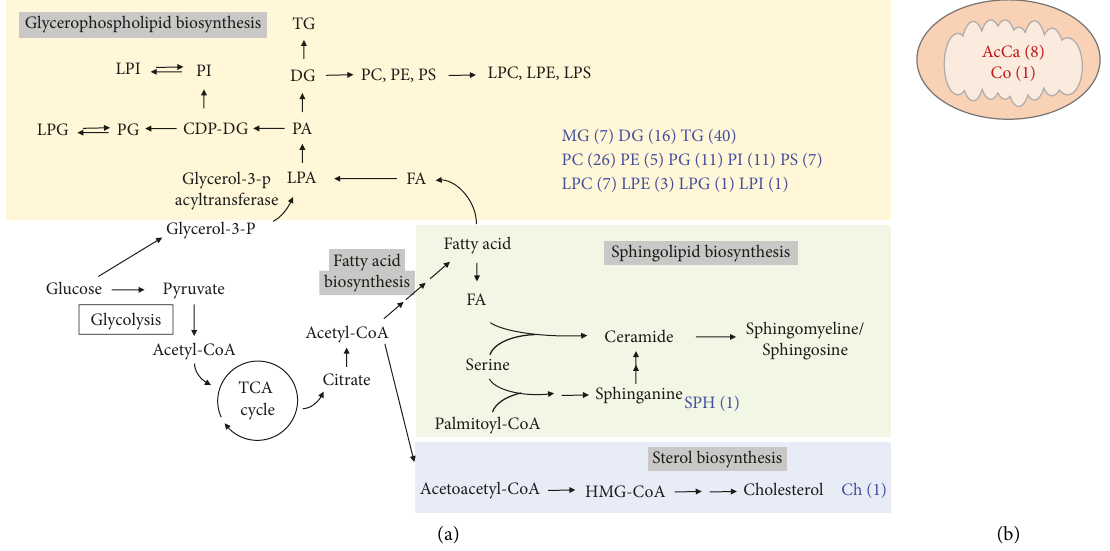
Figure 5: Schematic of the lipid biosynthetic pathways explored in the present study. (a) Lipid biosynthetic pathway. (b) Lipids are directly related to mitochondria. The blue and red texts are lipid classes detected in abalone tissue/hemolymph and the number of each lipid